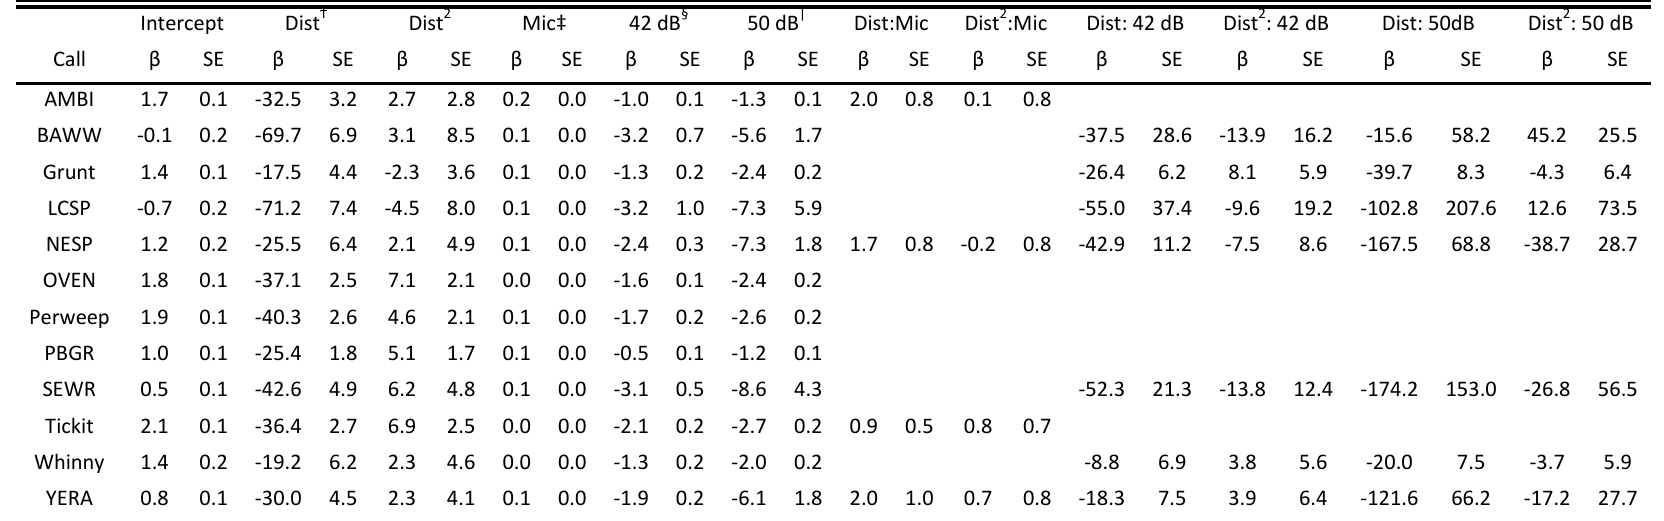
Appendix 1. Parameter estimates from selected models explaining variation in the detection/non-detection of species calls from experimental playback